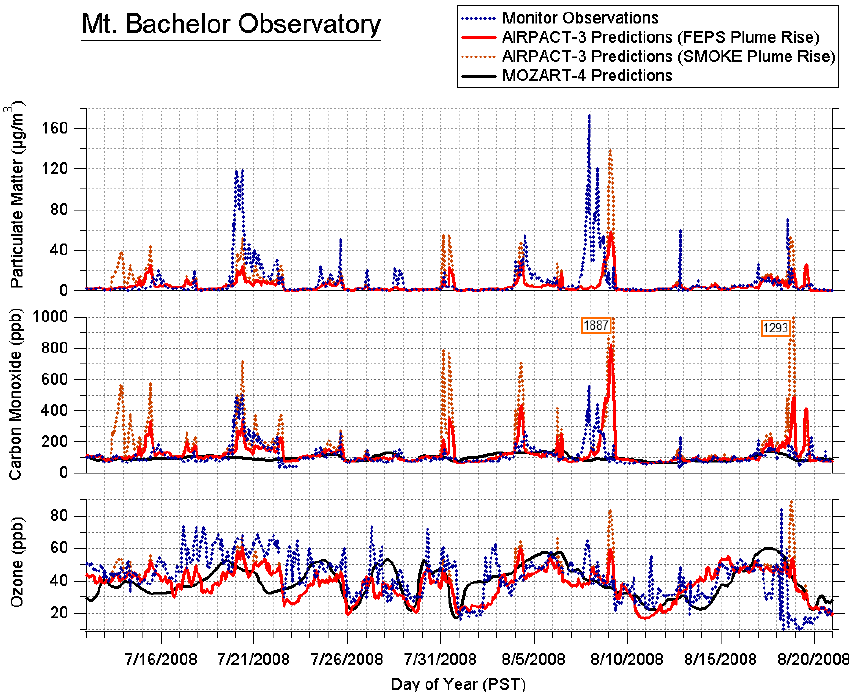
Figure 9. Particulate matter (top), carbon monoxide (middle), and ozone (bottom) at Mt. Bachelor Observatory for 12 July to 21 August 2008. AIRPACT-3 model simulations are shown in red (FEPS plume rise) and orange (SMOKE plume rise), MOZART-4 model simulations are shown in black, and observations are shown in dotted blue. Note that aerosols for AIRPACT-3 are reported as PM 2 . 5 and observed aerosols are sub-micron aerosols converted from scattering observations using the method described in Wigder et al.